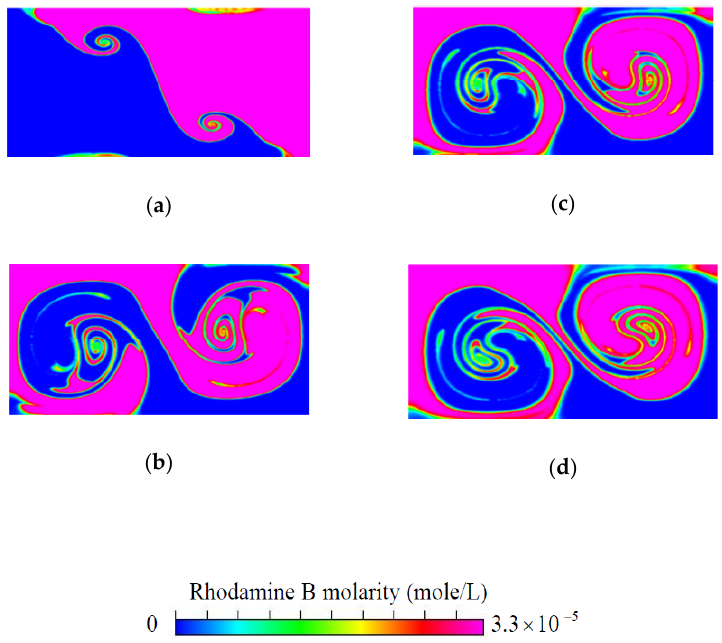
Figure 3. Concentration distributions on the cross-section at ( a ) y = 300 µ m, ( b ) y = 1500 µ m, ( c ) y = 2700 µ m, ( d ) y = 3900 µ m in a standard planar T-shaped mixer with H = 300 µ m at Re (cid:48) = 150 and Sc = 3200. Figure 3. C oncentration distributions on the cross-section at ( a ) 3200 Sc = .